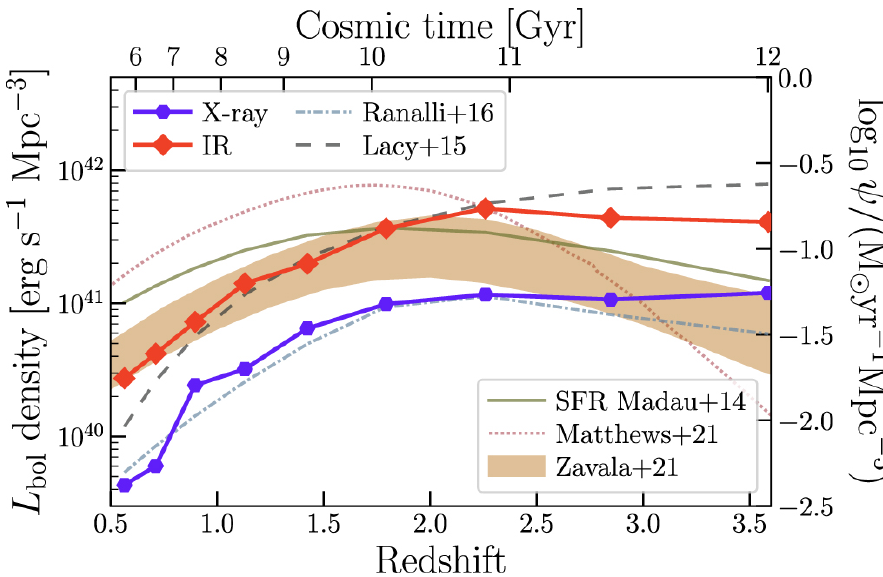
Figure 7. The AGN luminosity density (proxy for the black hole accretion rate density) as derived from the IR vs. X-ray AGN luminosity functions. Note that at all redshifts, the IR selected AGN dominate the luminosity density. Morever, the shape of this function (for the IR), is similar to the more recent determination of the SFRD [107] including the greater contribution of dusty galaxies at z > 2.5. Adapted from Runburg et al. [19]. Reproduced with permission by the